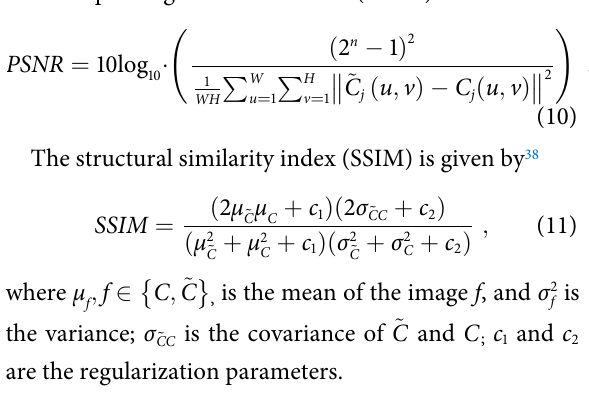
Fig. 12 | Distribution and margin histogram of the demodulated complex-amplitude signals. The horizontal axis represents the phase, and the vertical axis represents the amplitude. The histogram represents the distribution of the decoded data. The 16 colors rep- resent the 16 complex-amplitude classifications. The arrows repres- ent the direction of the wrong data point